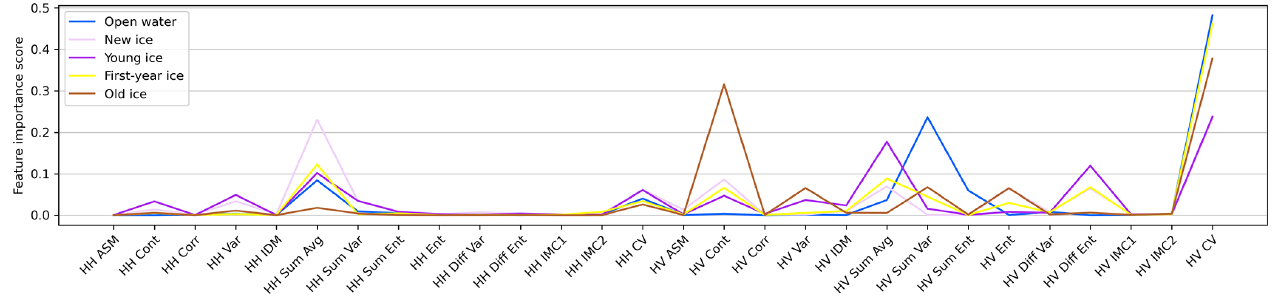
Figure 6. Feature importance of the binary sub-classifiers. ASM: angular second moment; Cont: contrast; Corr: correlation; Var: variance; IDM: inverse difference moment; Sum Avg: sum average; Sum Var: sum variance; Sum Ent: sum entropy; Ent: entropy; Diff Var: differ- ence variance; Diff Ent: difference entropy; IMC: information measures of correlation; CV: coefficient of variation. For definitions of each parameter, please refer to Haralick et al.